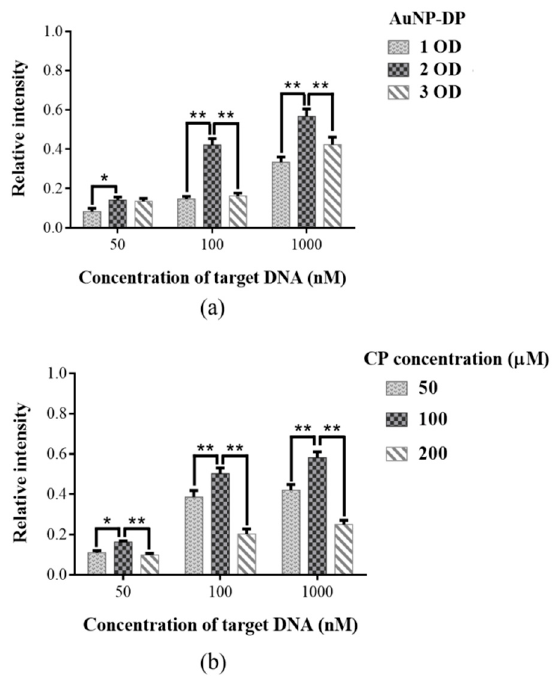
Figure 3. Optimization assays of ( a ) gold nanoparticle–detector probe (AuNP–DP) and ( b ) capture probe (CP); * p < 0.05; ** p < 0.01; data are presented as the mean and SD.